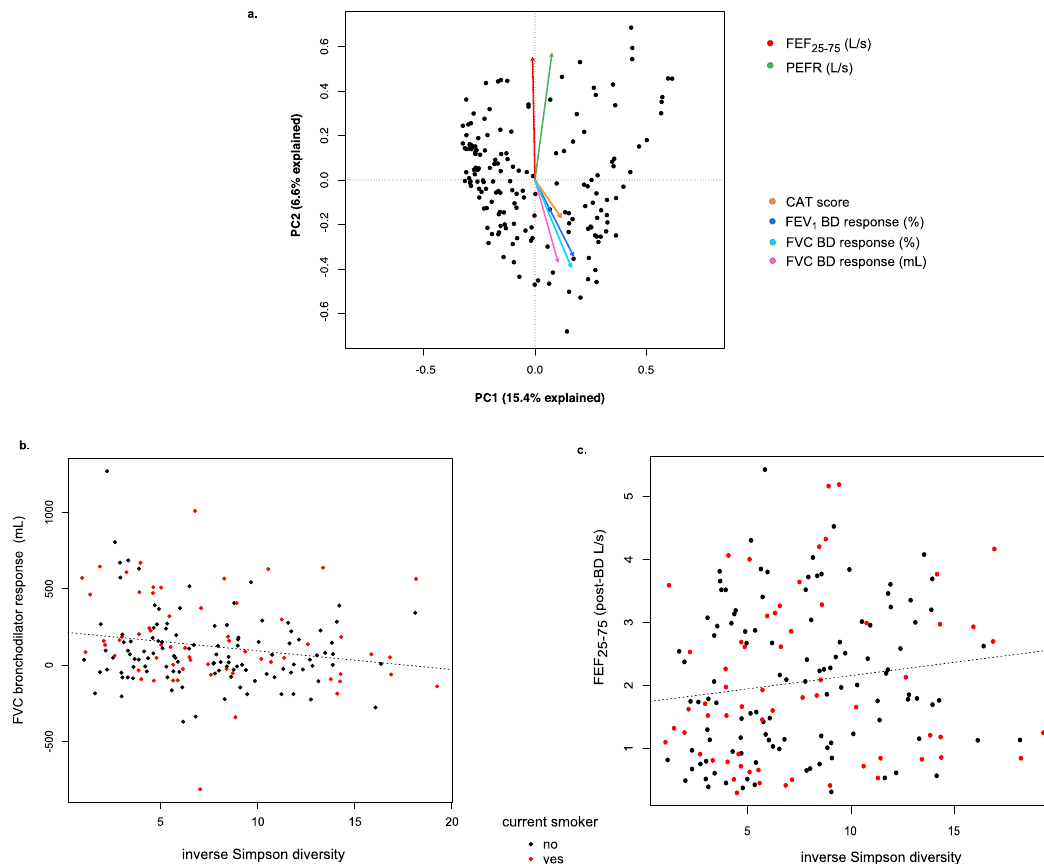
Fig. 1 Variation in lung bacterial community composition is associated with speci fi c measures of lung function and symptoms. a Principal component analysis (PCA) of the overall variation in BAL bacterial composition and relationships to the associated clinical measures for the entire cohort ( N = 181). Contrasting relationships exist between lung microbiota and measures of air fl ow limitation (FEF 25 – 75 and peak expiratory fl ow rate, PEFR) compared to that for measures of bronchodilator response and symptoms (COPD Assessment Test, CAT). PCA based on Hellinger transformation of OTU abundance counts. Vectors indicate direction and magnitude of the linear relationship between a clinical variable and the gradient of bacterial composition shown by PCA (R function env fi t ). b , c Correlations between within-sample bacterial diversity (inverse Simpson index) to FVC bronchodilator response and FEF 25 – 75 (Spearman r = − 0.26, p = 0.005 and r = 0.17, p = 0.02,